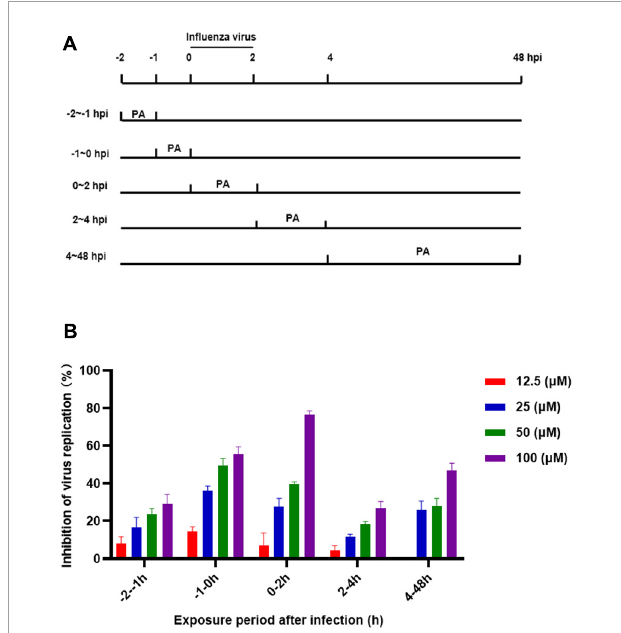
FIGURE5 Patchouli alcohol attenuates influenza virus A/Puerto